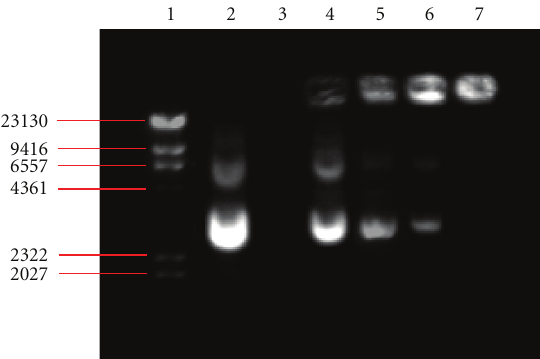
Figure 3: Transmission electron micrograph of the prepared chitosan-coated PBCA nanoparticles.